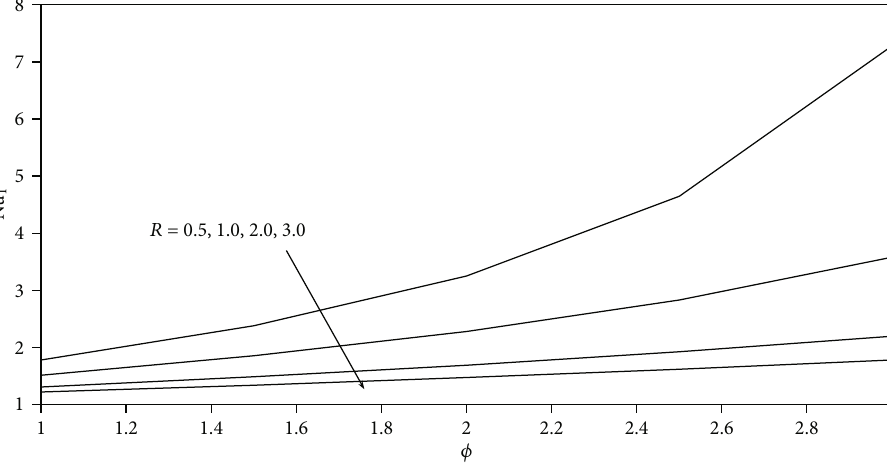
Figure 13: Variation of Nusselt number ð Nu